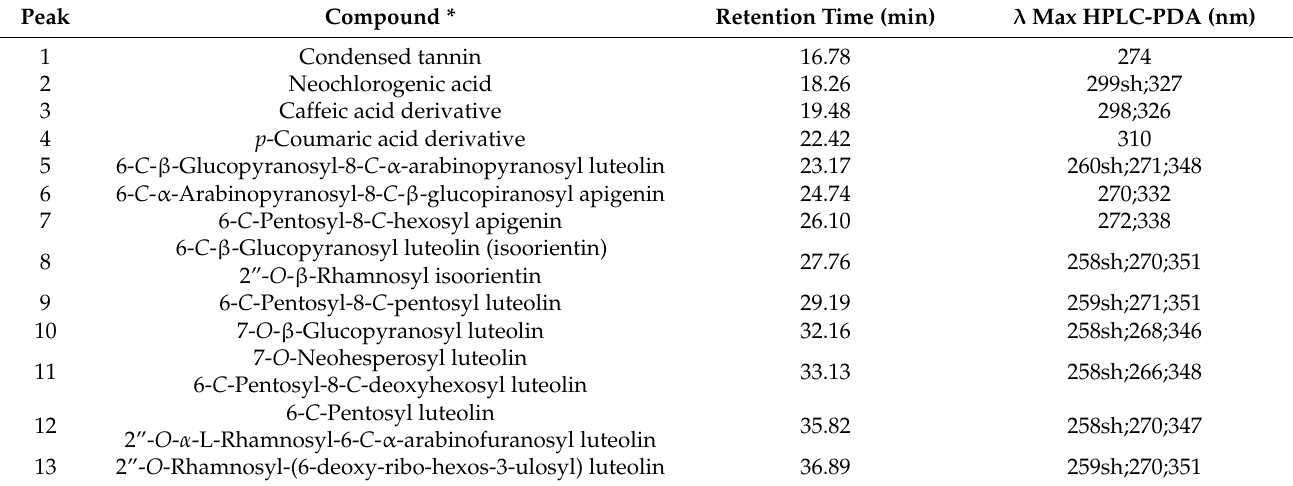
Table 1. Identification of phenolic compounds of Cymbopogon citratus extract (recorded at 280 nm).